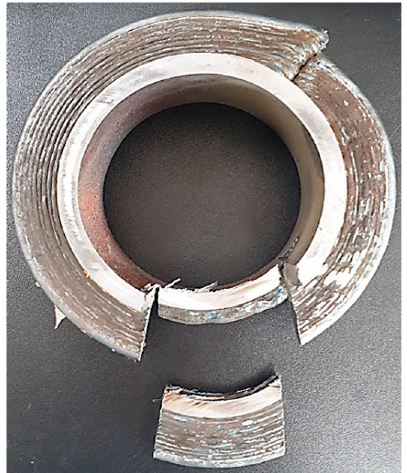
Figure 17. Sample sampler from the champion piece. Materials 2022 , 15 , x FOR PEER REVIEW